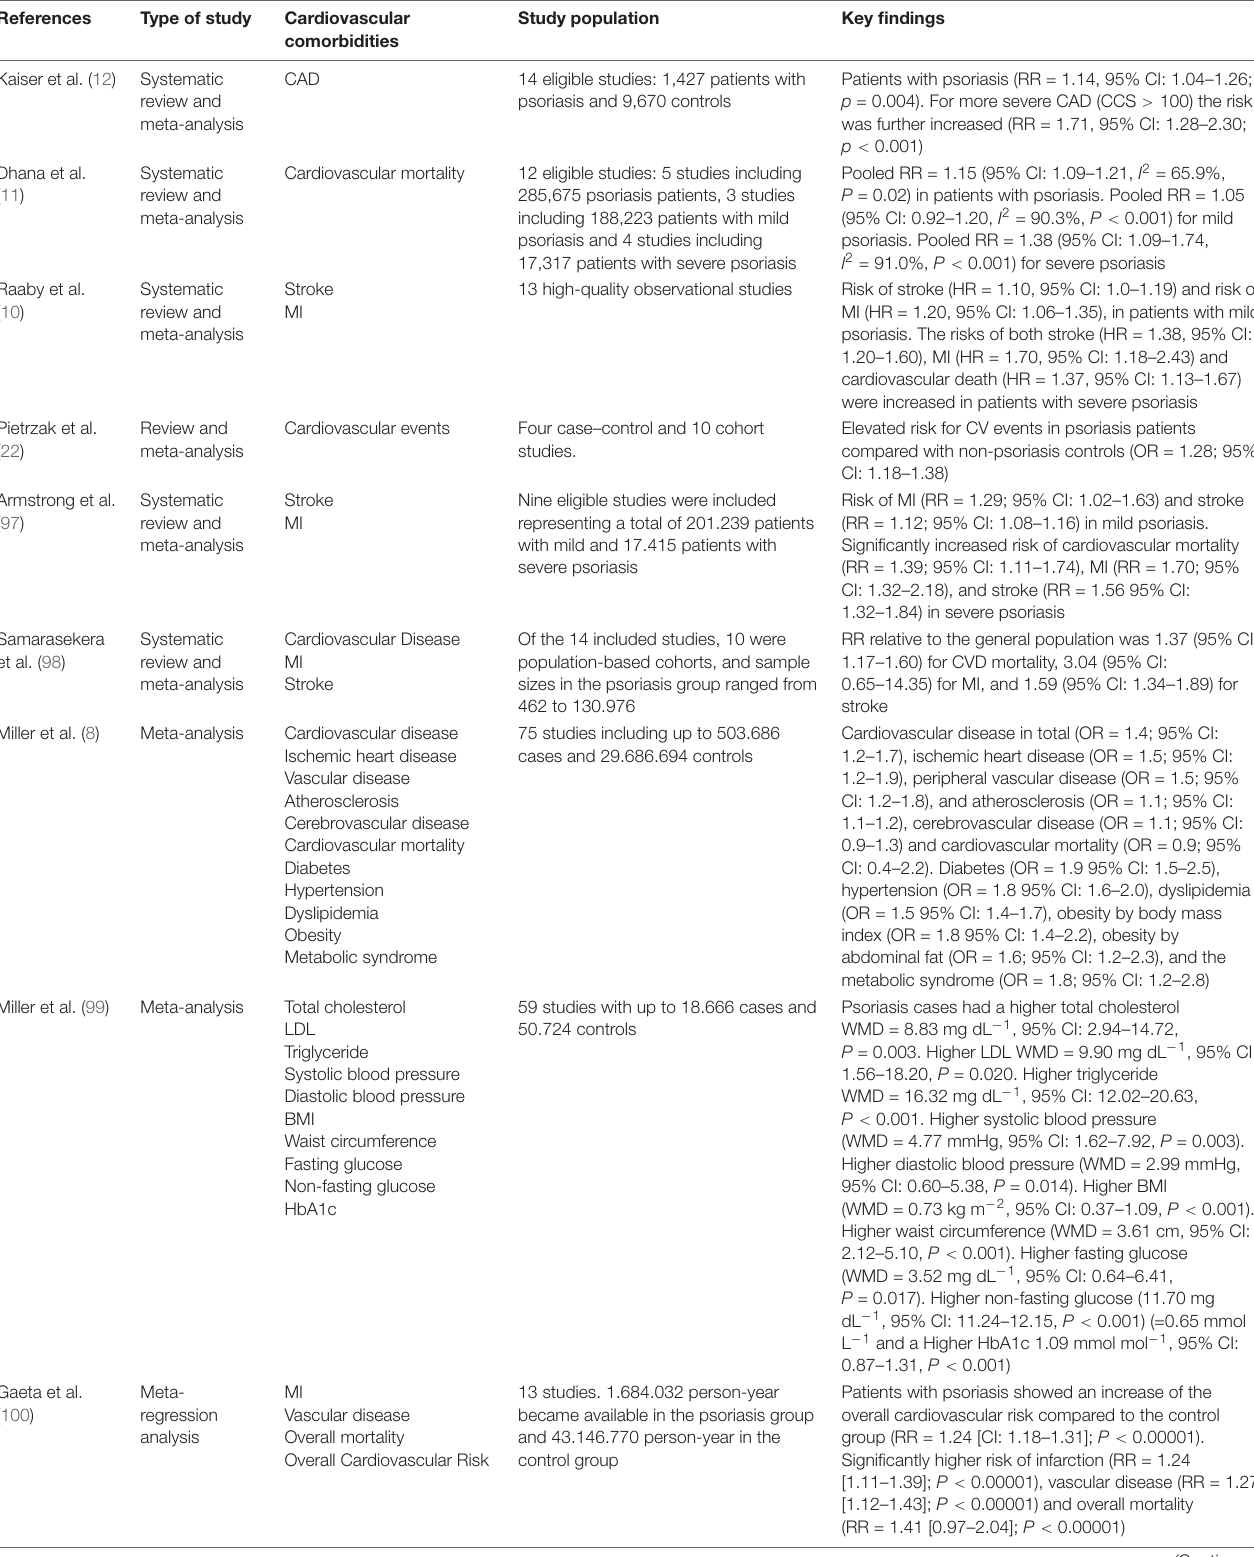
TABLE 1 | A synopsis of systematic reviews and meta-analyses investigating the association of psoriasis with conventional cardiovascular risk factors and adverse cardiovascular